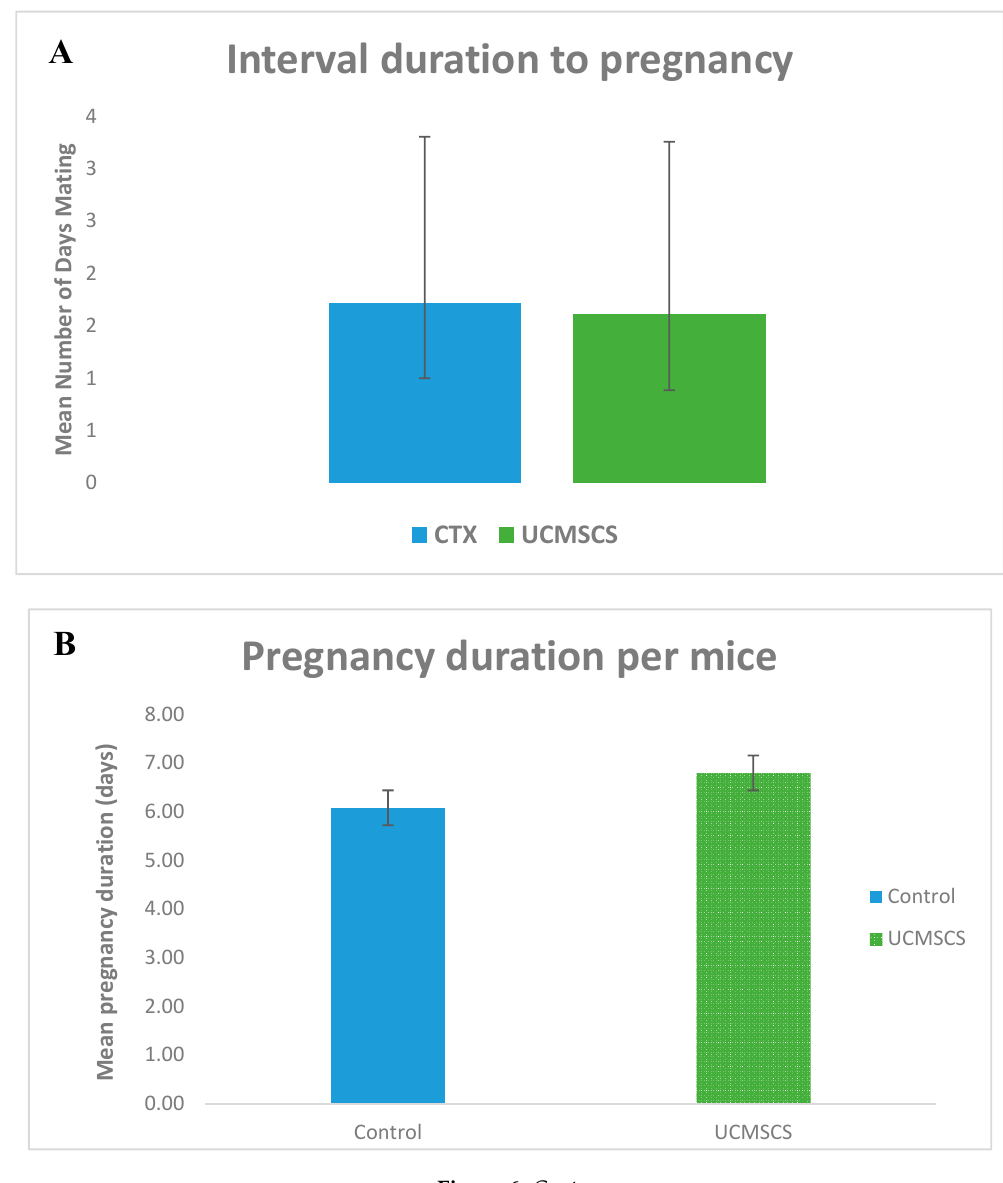
Figure5. UCMSCs recover ovarian secretory function as shown in ( A ) H&E for group 1 (control) average follicles number and normal tissue distribution, group 2 (CTX) no follicles could be determined and atrophied ovarian tissue, group 3 (UCMSCS) increased number of follicles with revived ovarian tissue. ( B ) and ( C ) and ( D ) group 1 and 3 confirmed increased expression of AMH and follicular-stimulating hormone receptor (FSHR) and Inhibin A in contrast to group 2 respectively. (Scale bar 40 µm)